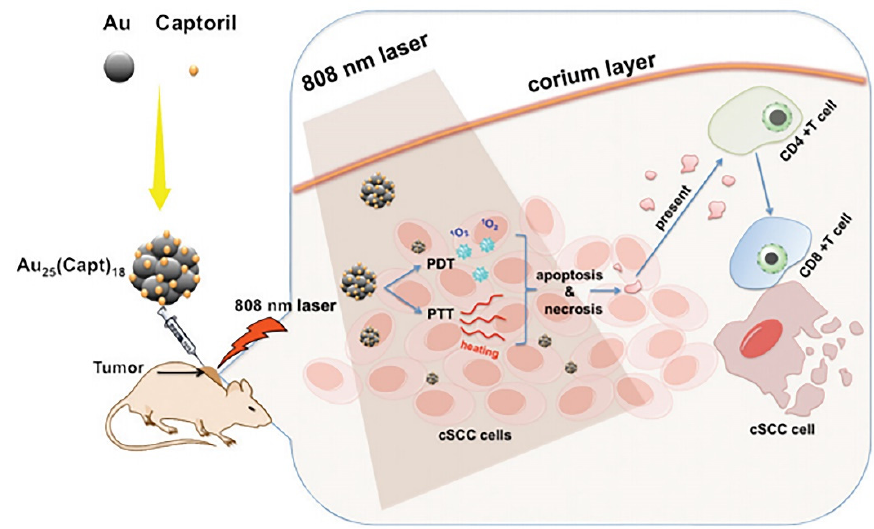
Figure 4. Diagrammatic representation of the combined photothermal and photodynamic treatment of nanoclusters of Au 25 (Capt) 18 under laser irradiation (808 nm) [96].